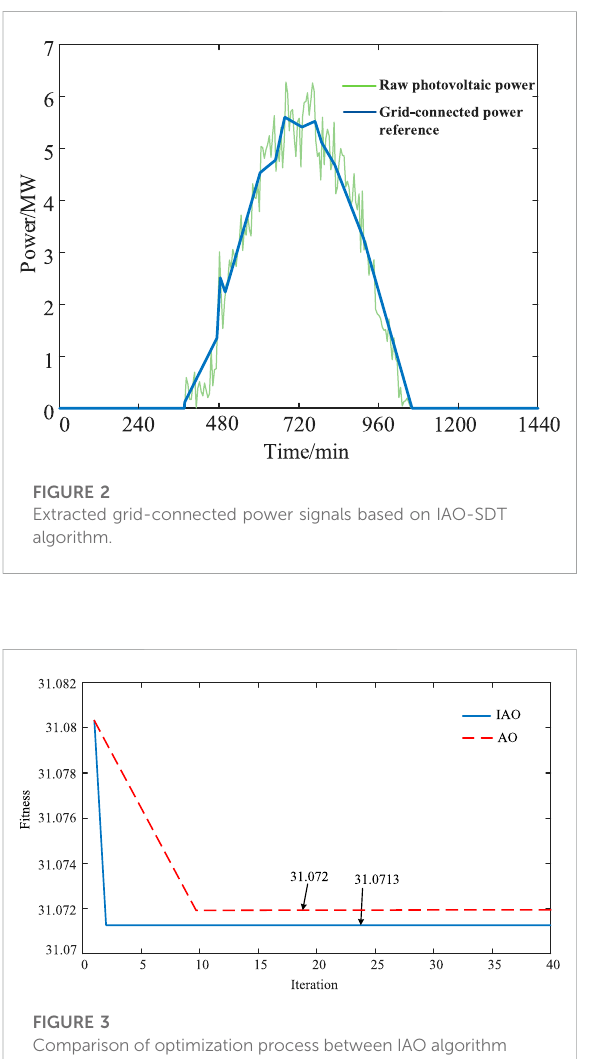
FIGURE 3 Comparison of optimization process between IAO algorithm and AO algorithm.